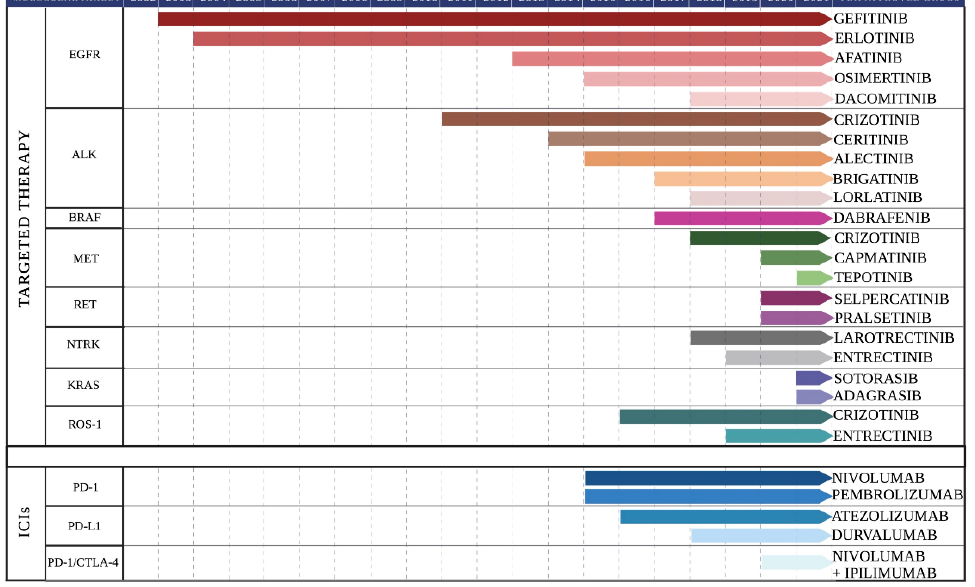
Figure 4. Timeline of the FDA-approved targeted therapies and immune-checkpoint inhibitors (ICIs) for the treatment of lung cancer. In dark blue, top row, the timeline (from 2002 to 2021) is indicated. On the left, the approved drugs are indicated, divided based on their molecular target. On the right each single drug name is reported. In the middle, an arrow is associated to each drug and the year of approval (different